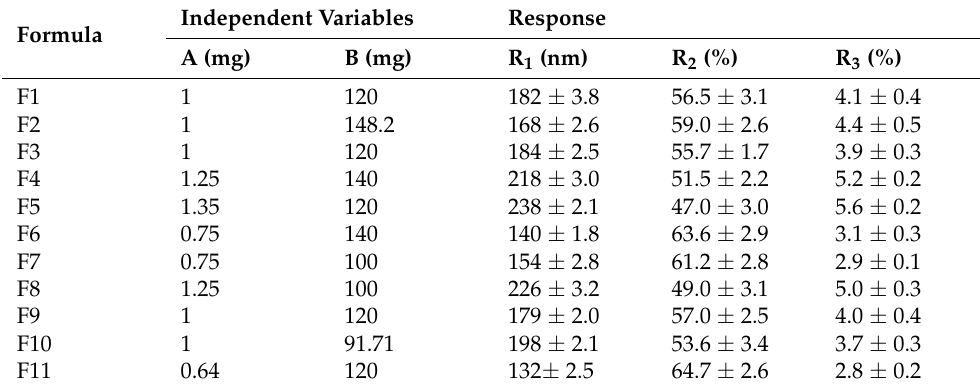
Table 2. Experimental design for PEGylated PX-NE formulations along with their corresponding observed values of response. Independent Formula